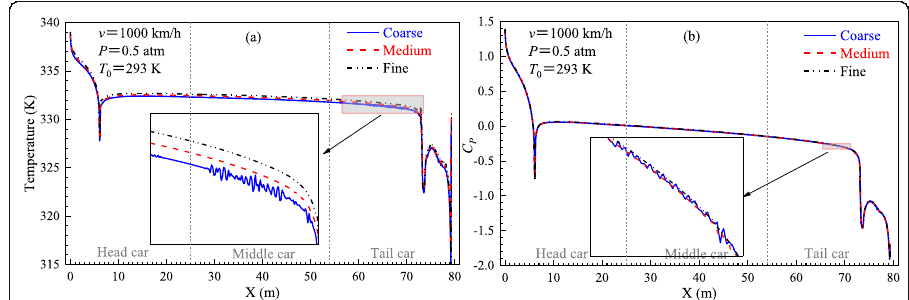
Fig. 7 Temperature ( a ) and C P ( b ) distribution on the intersection line between the train upper surface and the xy plane